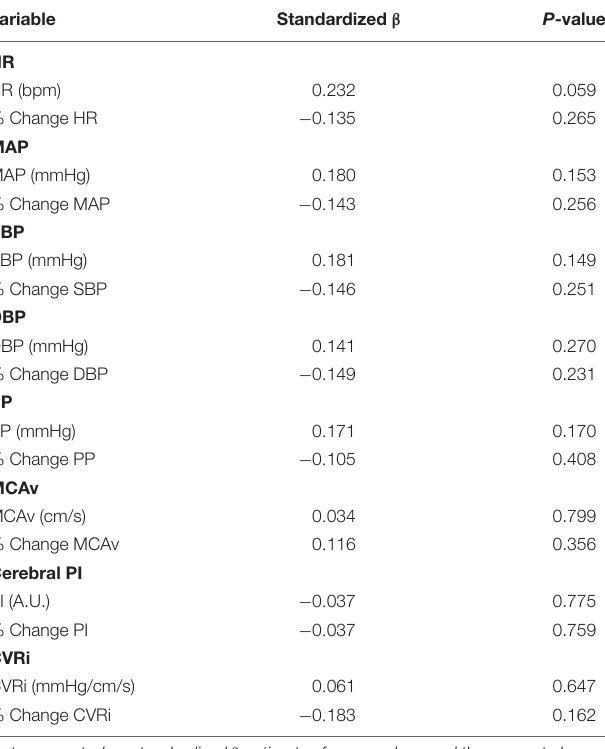
TABLE 4 | Results of multiple linear regression analysis between cardiovascular and cerebrovascular variables during isometric handgrip exercise and white matter hyperintensity fraction.